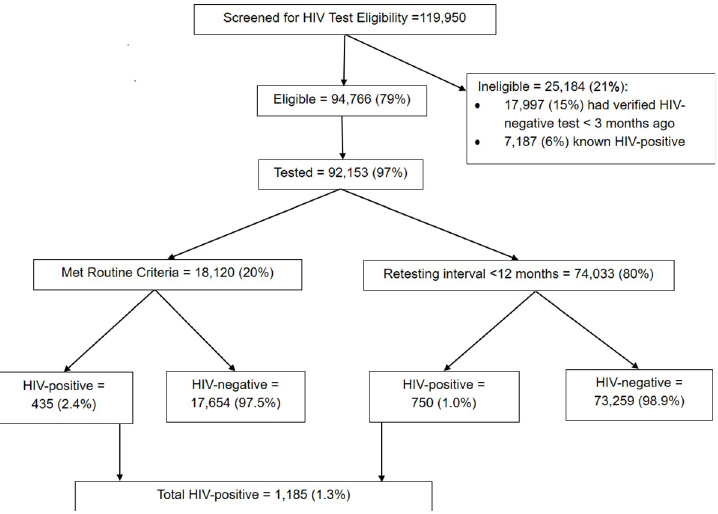
Fig 1. HIV Testing cascade. Of the 92,153 persons tested for HIV, 57% were female, and 60% were patients; the median age was 28 years (IQR 21–38) Table 1. A greater proportion of clients meeting RRI criteria were females (58% vs. 51%; p-value < 0.001), aged 20–24 (23% vs 20%; p-value < 0.001) and 25–49 (51% vs 45%; p-value < 0.001) years, and non-patients (40% vs. 38%; p-value < 0.001).